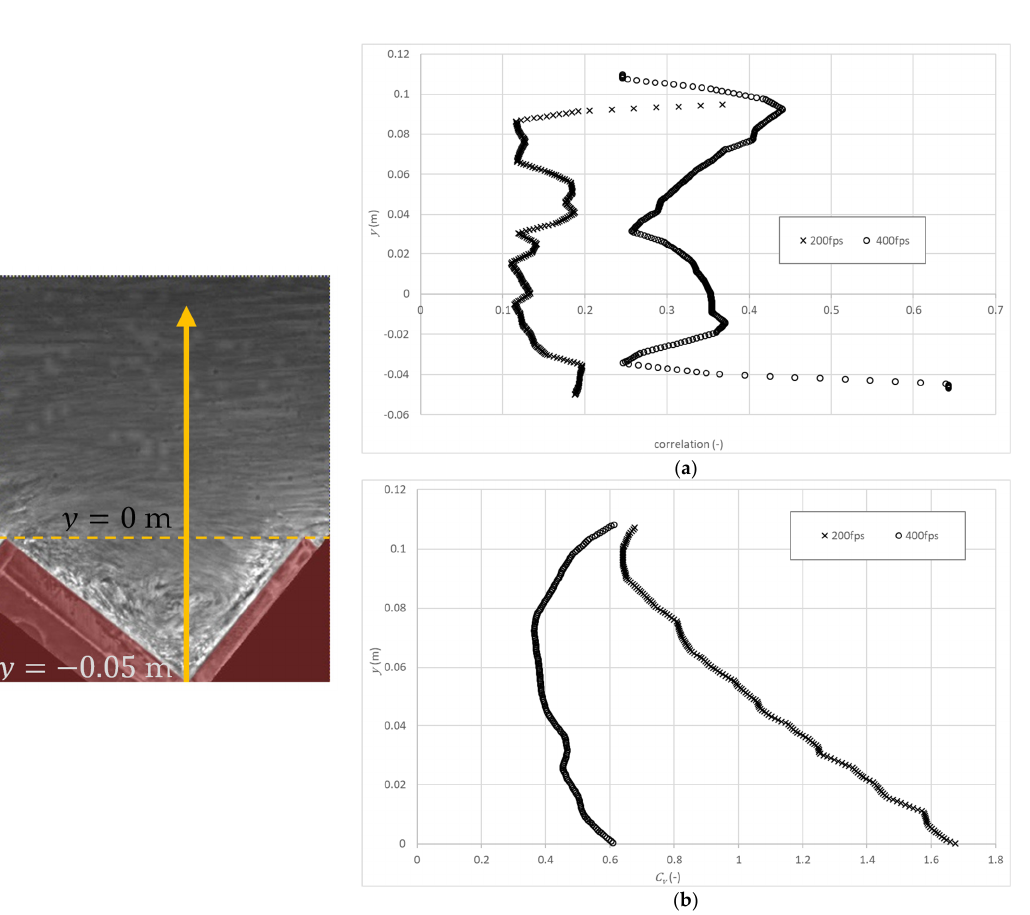
Figure 11. Longitudinal component of velocity ( u ) obtained at L / L t = 0.49 along the normal to the pseudo − bottom from the internal edge of the step for 200 fps and 400 fps, for interrogation areas reduced in 2 steps from 194, to 97, and then to 49 pixels ( a ); in 2 steps from 256, to 128, and then to 64 pixels ( b ) and in 3 steps from 288 to 144, then to 72, and then to 36 pixels. The scheme includes the layout of the vertical where the velocities were obtained. The dashed line represents the pseudo − bottom (y = 0).